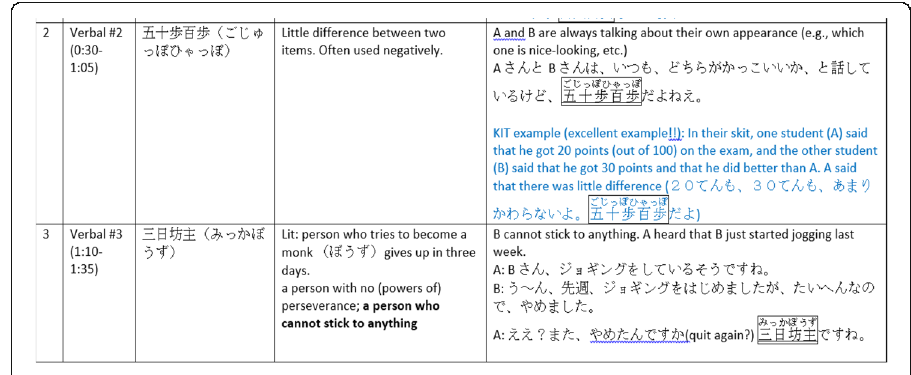
Fig. 3 Screenshot of Part of the Expression